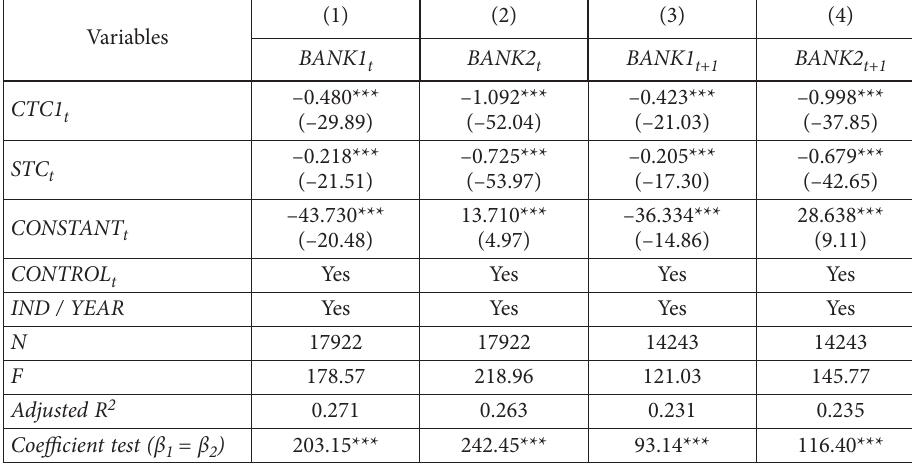
Table 7. Testing heterogeneous trade credit’ effect on bank credit